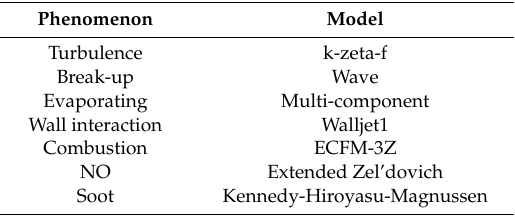
Table 3. Sub-model for numerical analysis